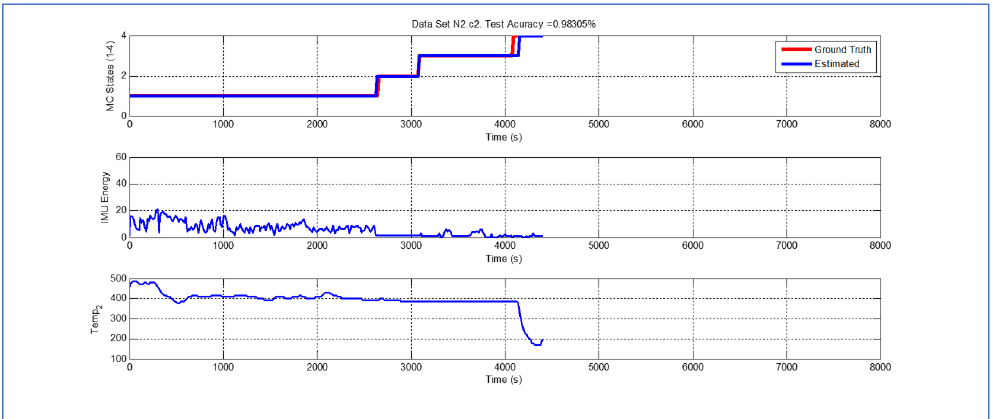
Figure 9. Detection of berry harvesting stages. Dataset N 2 c 2 .